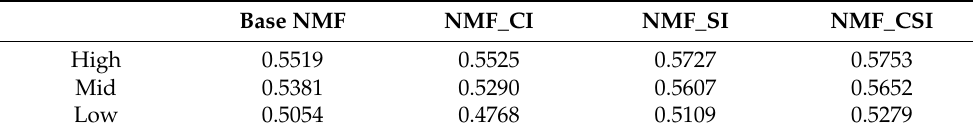
Table 4. Results by group of models reflecting domain information